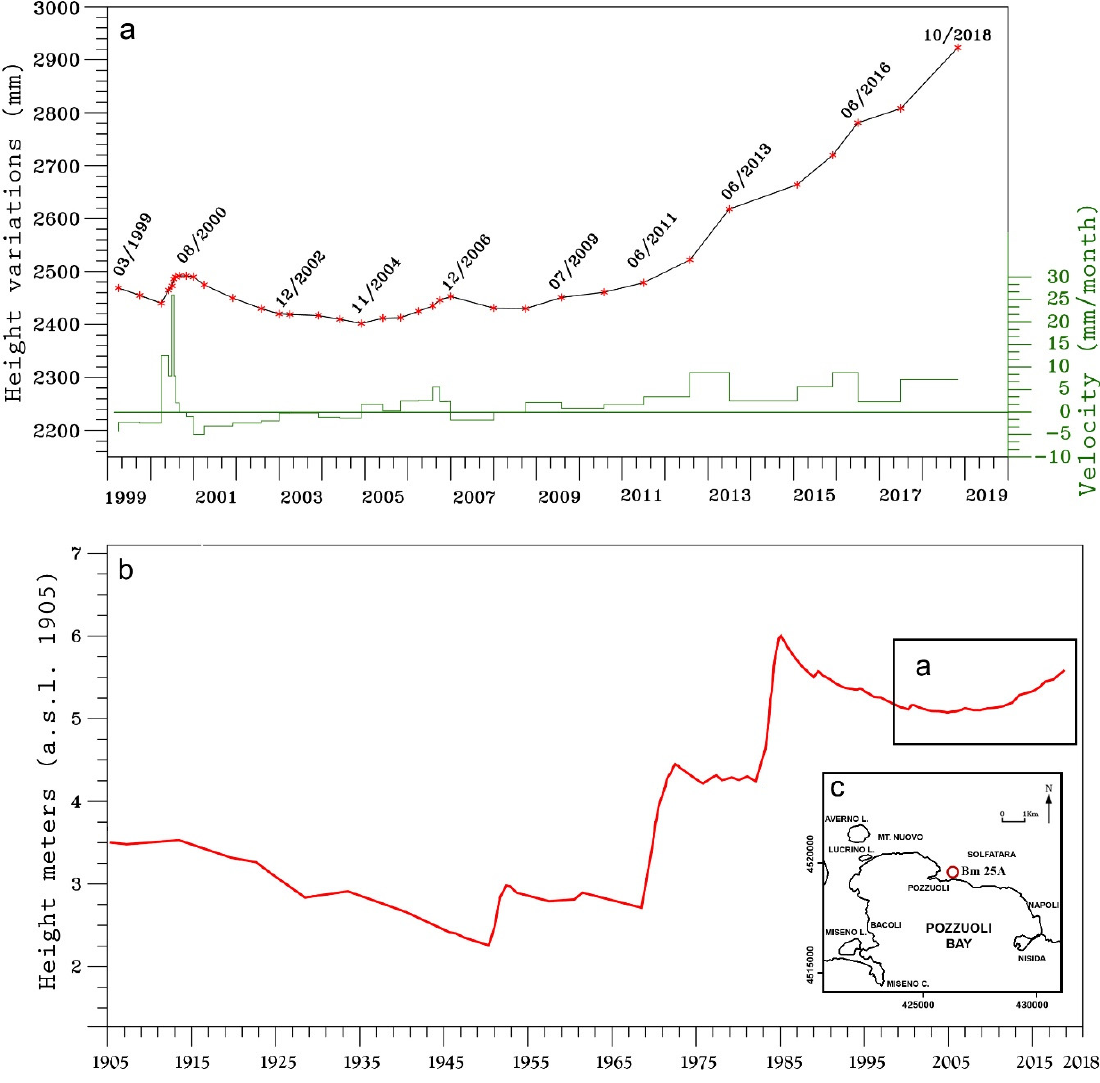
Figure 2. ( a ) Height variation of the benchmark 25A (Bm 25A) which records the maximum vertical displacement in the Campi Flegrei area in the last twenty years; the ground uplift rate in mm / month are shown in green. ( b ) Height variations observed from 1905 to 2018 ([31] modified and supplemented with data from leveling surveys carried out after 2009). ( c ) Schematic map with the Bm 25A location (red circle) coincident with the maximum uplift measured.